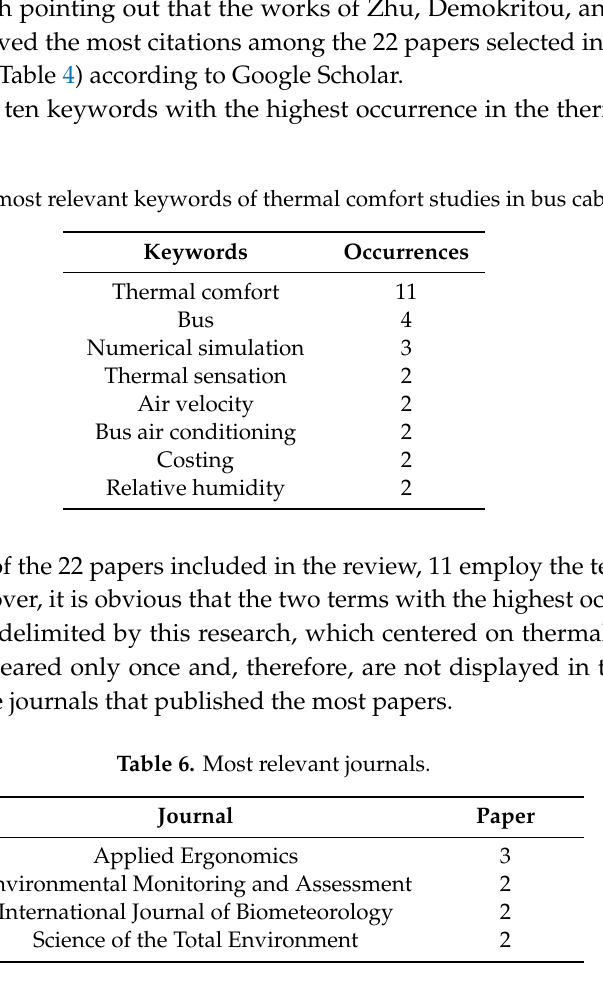
Table 5. Top 10 of the most relevant keywords of thermal comfort studies in bus cabin environments.